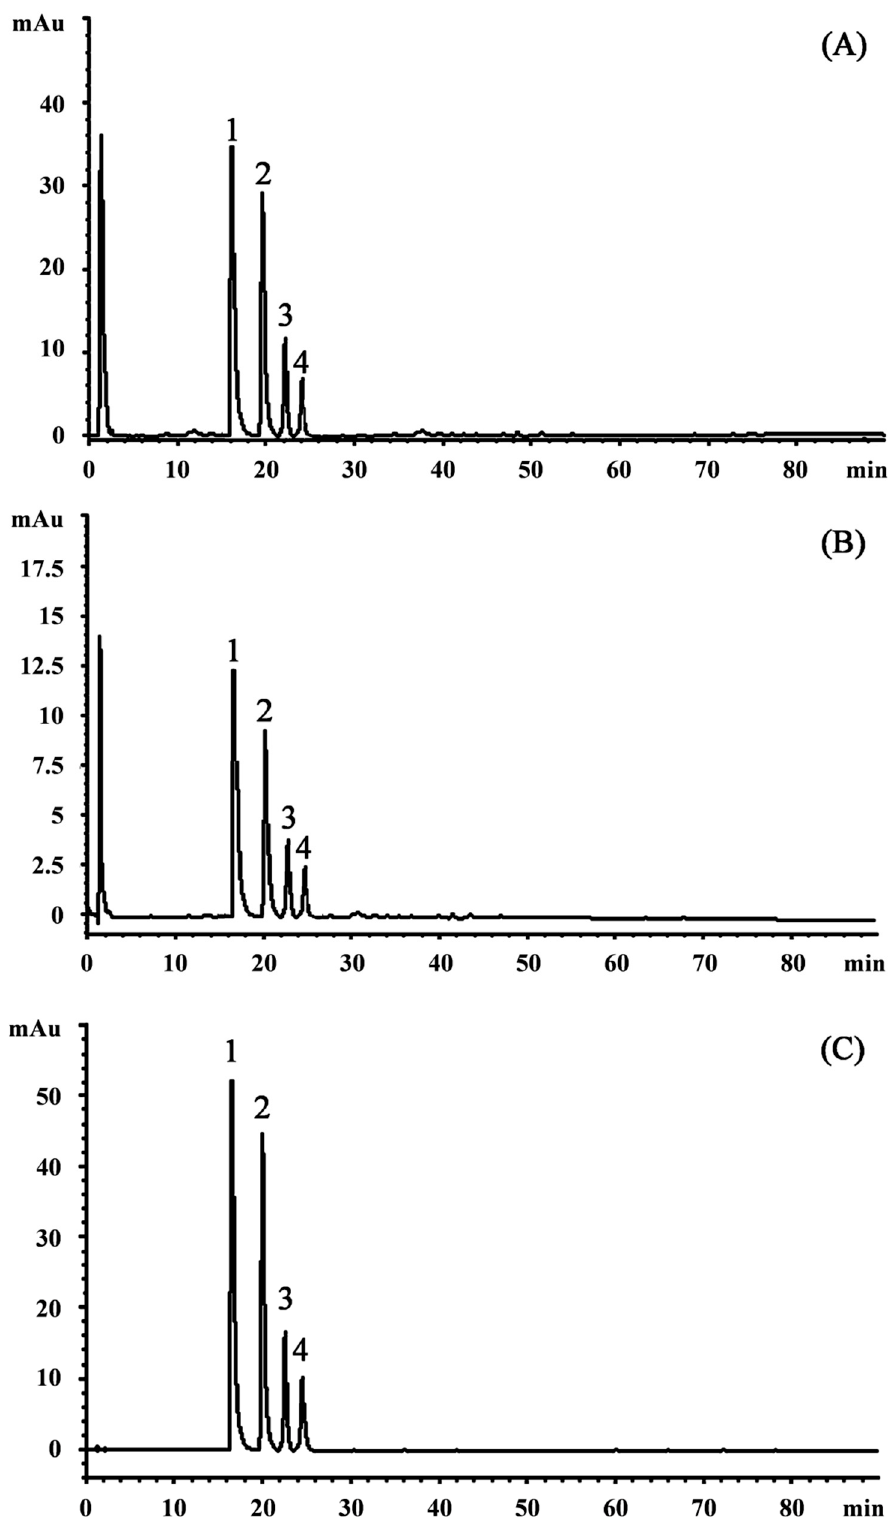
Figure 1. Representative RP-HPLC-DAD-ESI-MS / MS chromatogram of enriched fraction of acidified methanolic extract of C. citrinus flowers (EAC) acquired at 292 nM ( A ), 330 nM ( B ), and 520 ( C ) nM. 1 cyanidin-3,5- O -diglucoside (cyanin), 2 peonidin-3,5- O -diglucoside (peonin), 3 cyanidin-3- O -glucoside, 4 cyanidin-coumaroylglucoside-pyruvic acid.